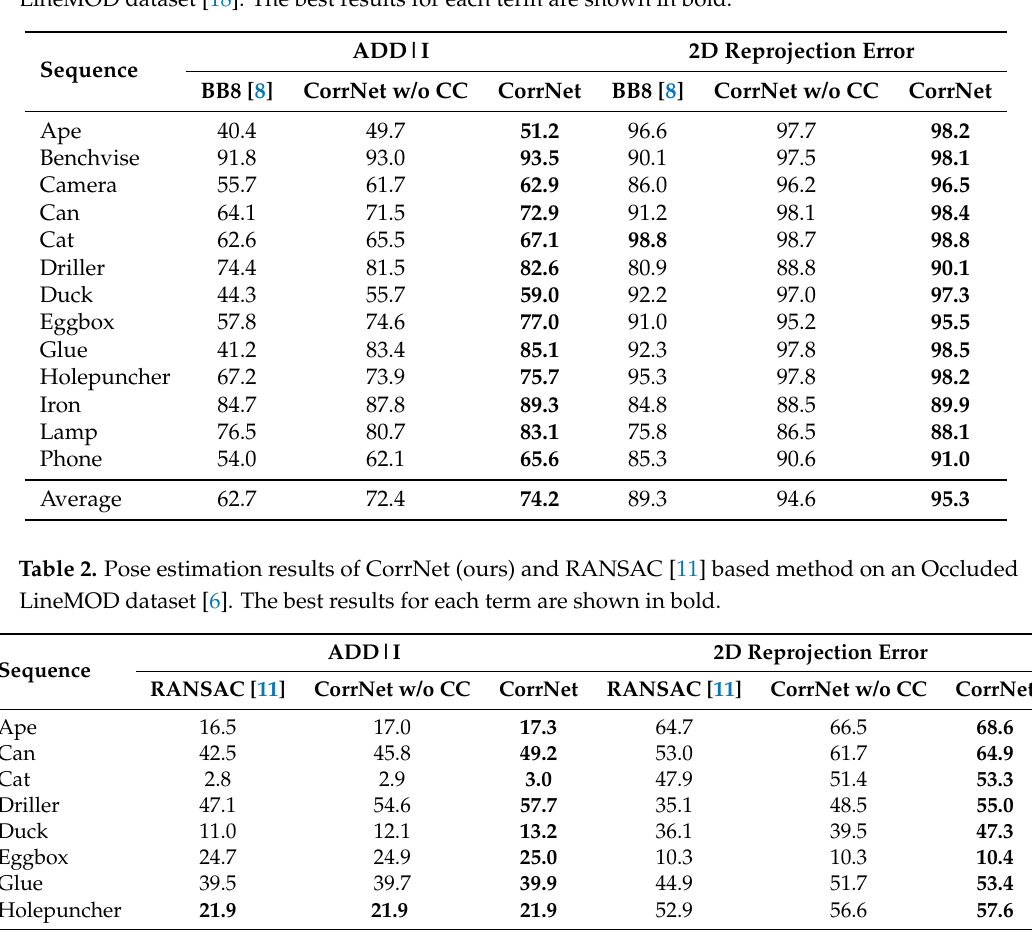
Table 1. Pose estimation results of two different versions: CorrNet and CorrNet w/o CC on the LineMOD dataset [18]. The best results for each term are shown in bold.